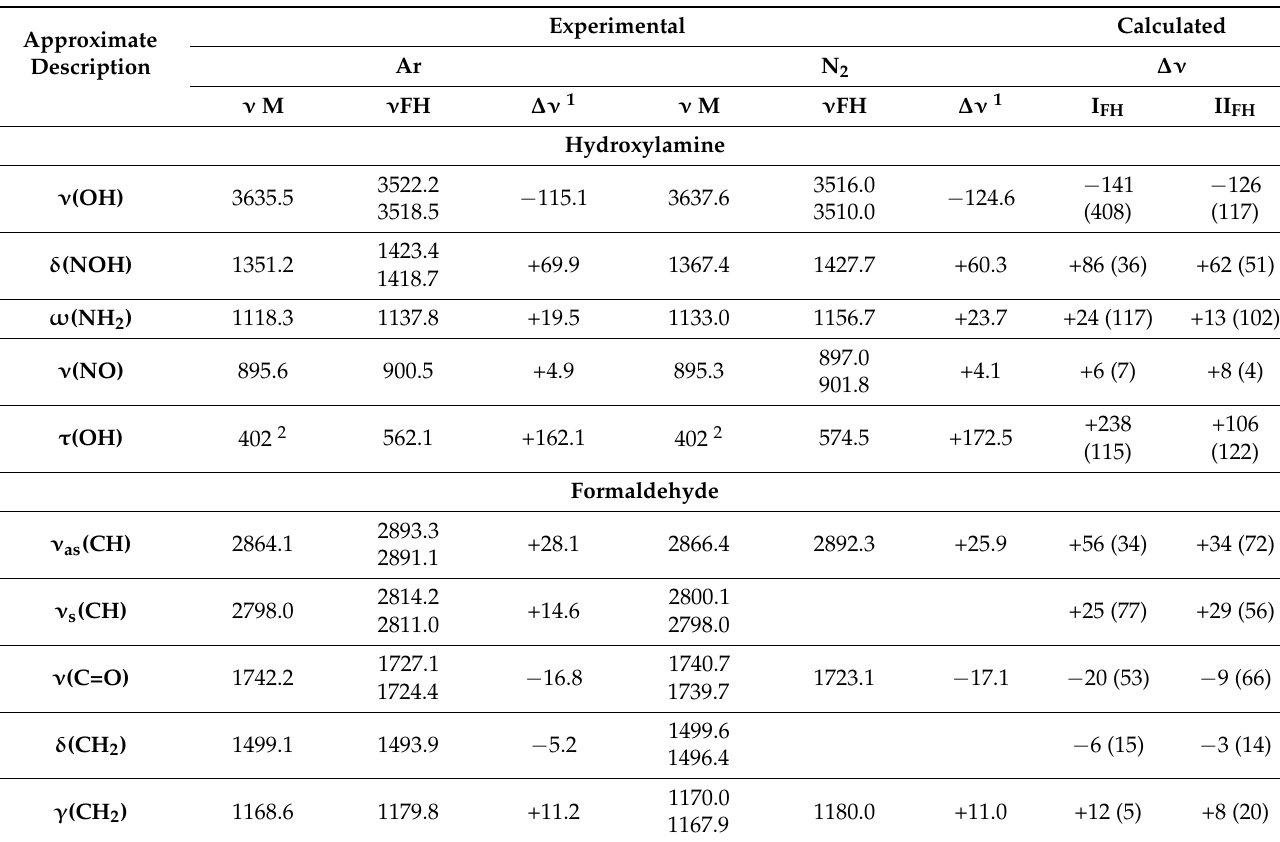
Table 1. The comparison of the observed wavenumbers (cm − 1 ) and wavenumber shifts ( ∆ ν = ν FH − ν M) for the HCHO– the structures I FH and II FH . In parentheses, the calculated band intensities are given (km mol − 1 ).